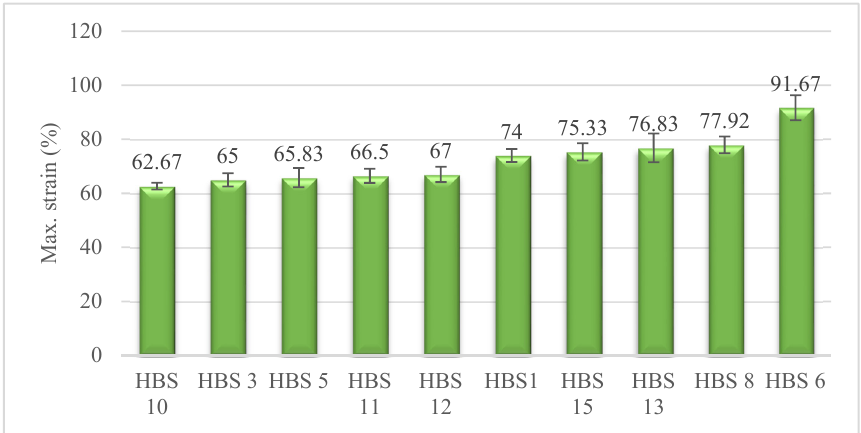
Figure 5. Average maximum tensile strain of HBSs .